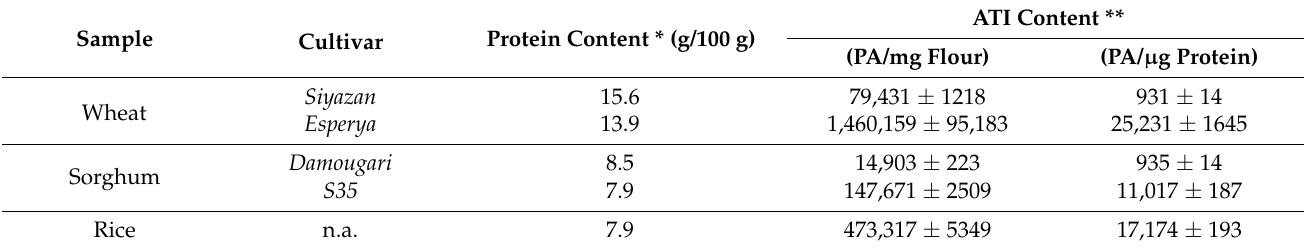
Table 1. Protein content and relative ATI content of selected feed